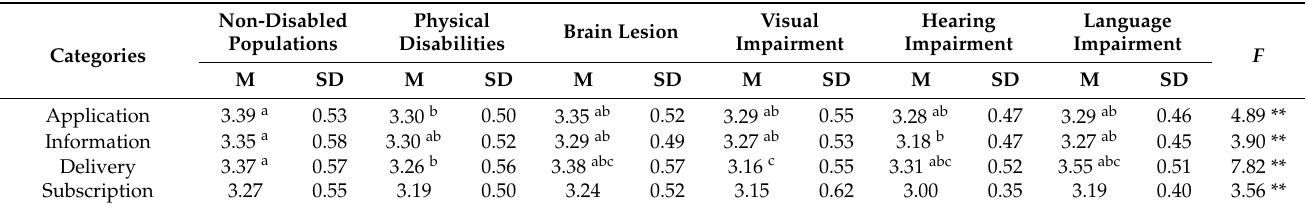
Table 5. Usefulness of COVID-19-related non-face-to-face